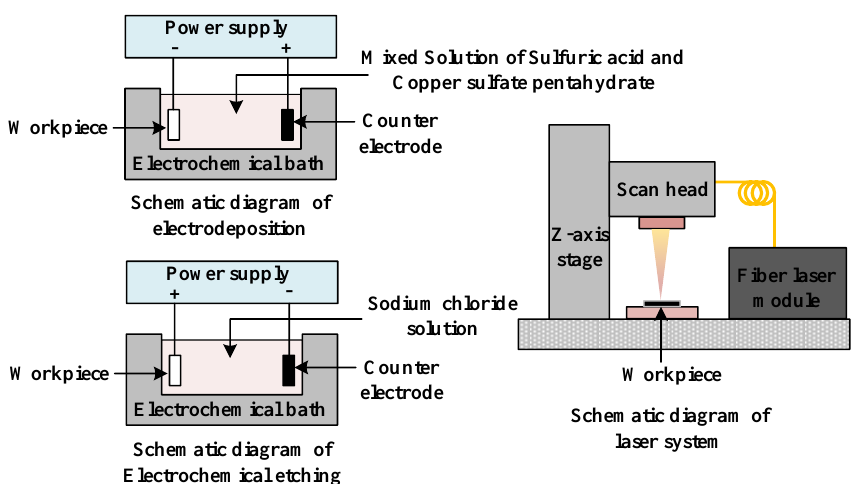
Figure 1. Experimental setup for deep electrochemical etching (DEE).